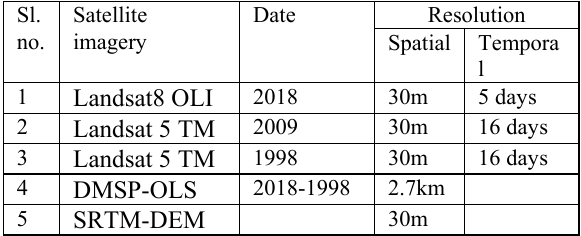
Table 1. Selected satellite imageries